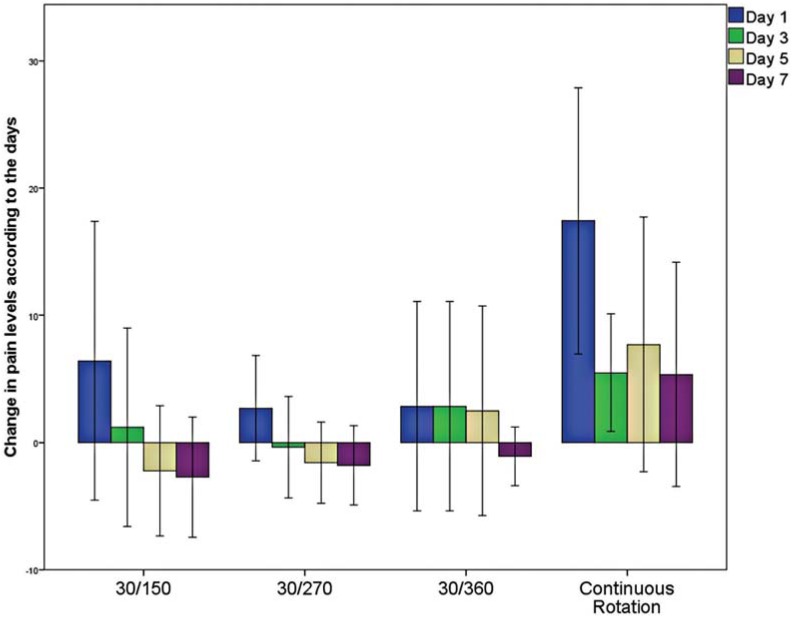
Change in pain levels according to the days. Change in pain was calculated at the day based on the preoperative pain. Continuous rotation increased pain at Day 1 in comparison with other reciprocating groups (360° CCW – 30° CW and 270° CCW – 30° C)